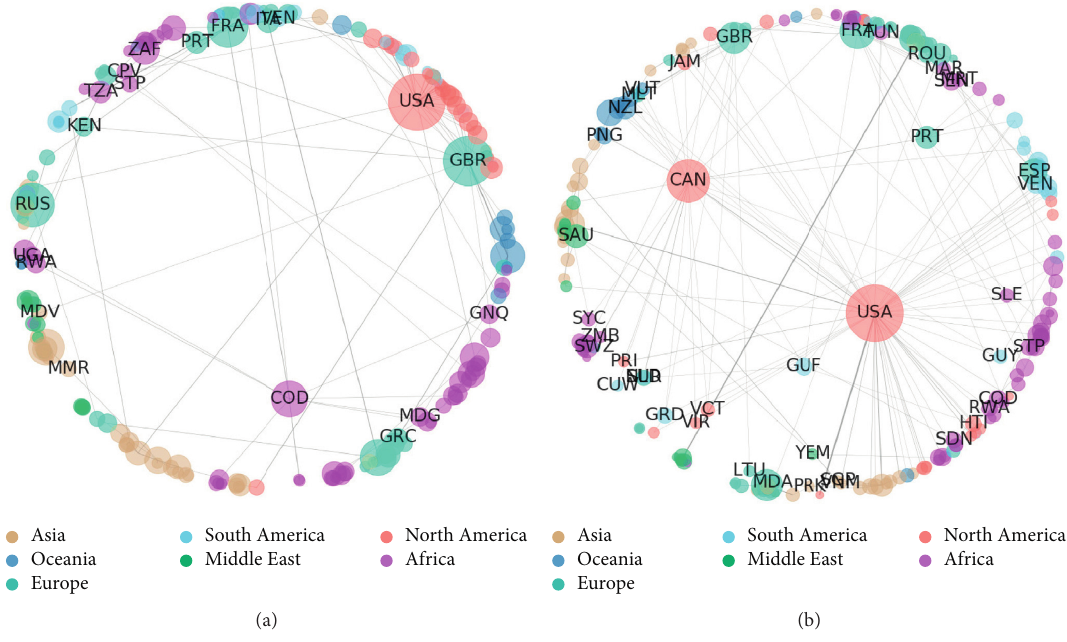
Figure 5: Hyperbolic embedding map of global migration network. (a) 1960–1969. (b)